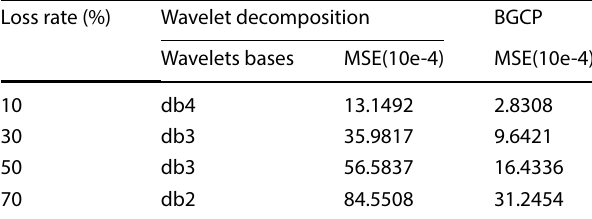
Table 4 MSE of wavelet decomposition and BGCP decomposition Loss rate (%)